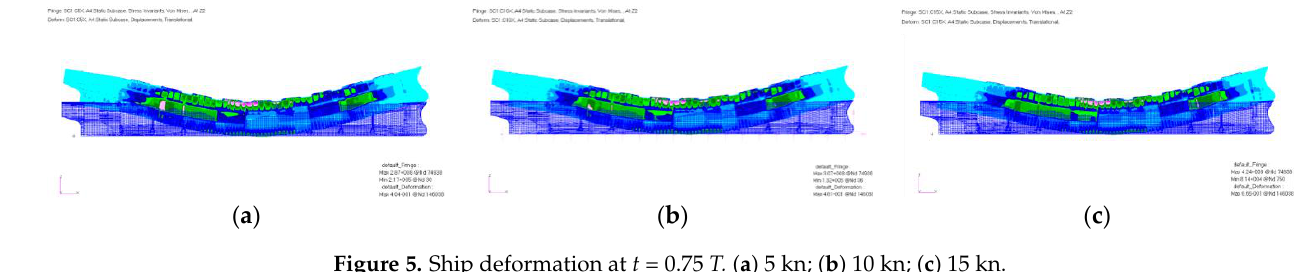
Figure 5. Ship deformation at t = 0.75 T. ( a ) 5 kn; ( b ) 10 kn; ( c ) 15 kn.